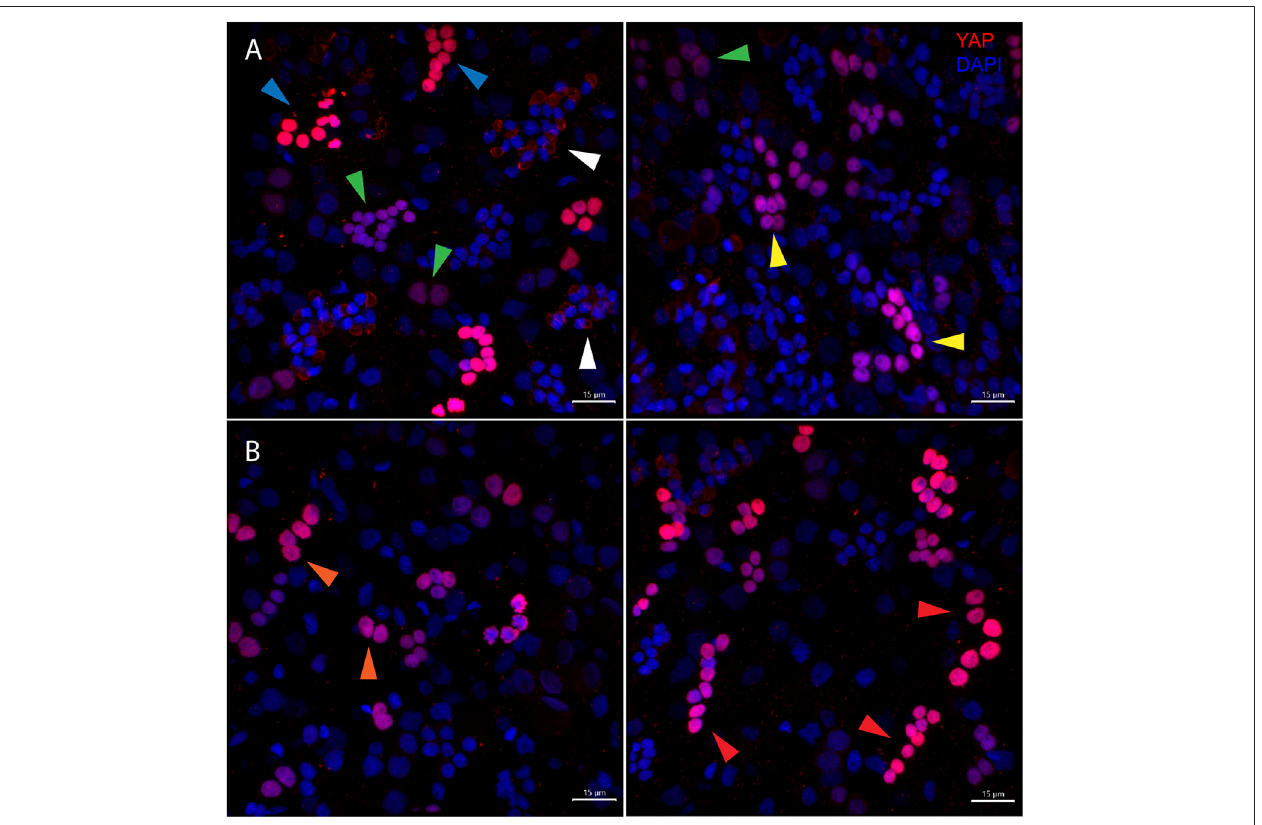
FIGURE 6 | Types of Hvul _YAP expressing cells in Hydra . Immuno fl uorescence assay of Hvul _YAP performed using anti-CheYki antibody on macerated cells at 60 × . (A) This panel shows cell types based on signal intensity or YAP expression level in cells. Blue arrow represents cells with high YAP expression, yellow arrow representscells withmedium YAP expression, cells withagreen arrow represents lowYAP expression. White arrow indicatesextra-nuclearstaininginnematocysts. (B) This panel depicts cell types based on the cellular arrangement. Orange arrows represent cells with duplet or quadruplet arrangement and red arrow represents cells arranged linearly. Red: YAP & Blue: Nucleus (Magenta indicates merged image). Immuno fl uorescence assay using the anti- Hvul _YAP antibody of macerated cells at 60 × . The red fl uorescent dye shows Alexa 594 staining of YAP and the blue dye shows DAPI staining of nucleus (Scale bar, 20